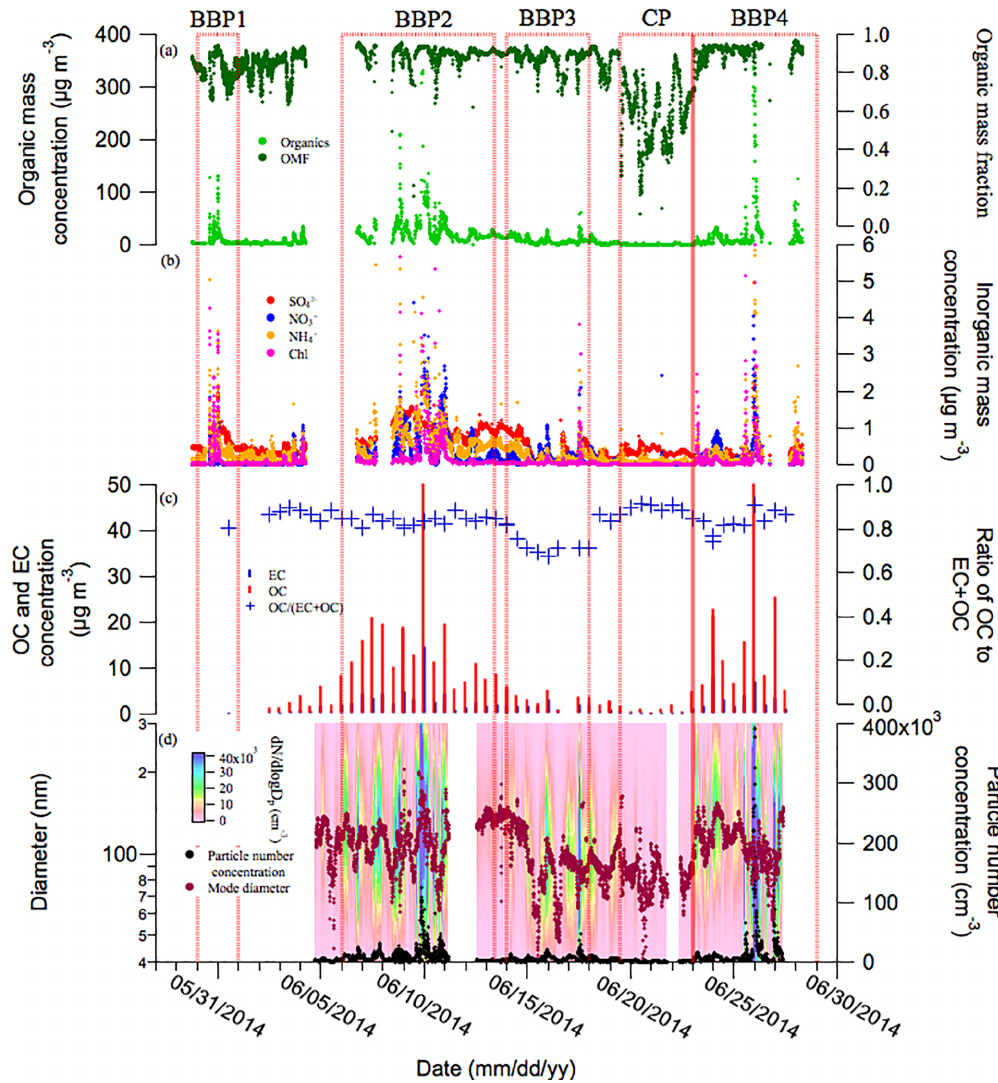
Figure 4. The times series of the major aerosol properties during the SAFIRED campaign: (a) the non-refractory PM 1 organic mass concen- tration (left) and organic mass fraction (right), (b) the inorganic non-refractory PM 1 mass concentrations, (c) the 12h filter OC and EC PM 1 mass concentrations (left) and the ratio of OC to OC + EC (right), (d) the particle size distributions and particle size mode (left) and the total particle number concentration (right) at ATARS. The date and time is local